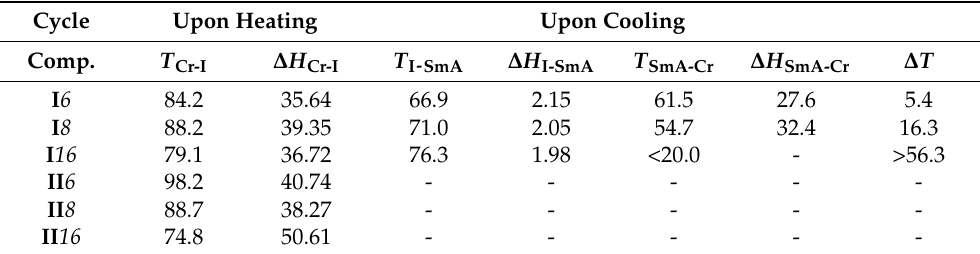
Table 1. Phase transition temperatures ( ◦ C), enthalpy of transition ∆ H, kJ/mole, and